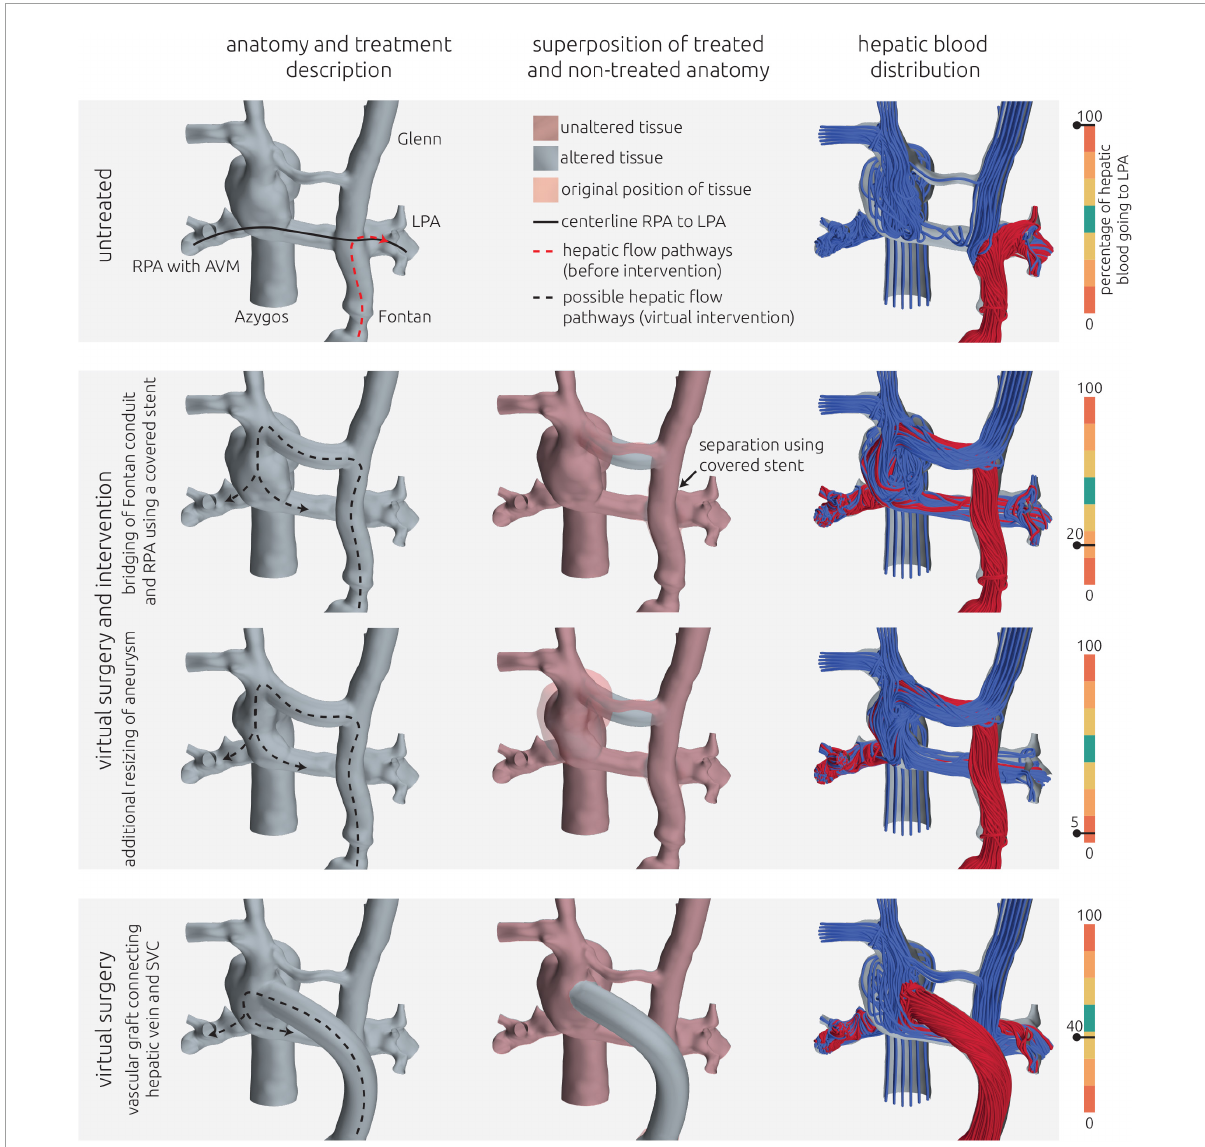
FIGURE7 Visualization of the estimated distribution of hepatic venous blood flow to the pulmonary arteries for the untreated patient-specific anatomy (top row) as well as two combined approaches using surgery and interventional techniques (middle rows) and one surgical treatment option (bottom row) for patient 2. In the left column, the anatomy of the conduit is shown together with the centerline from LPA and RPA (constant line) and the possible flow pathways for hepatic blood (dashed lines). The original pathways are highlighted in red, whereas the altered pathways after virtual treatment are shown in black. In the central row, the untreated anatomy is superimposed as transparent red surface over the virtually modified anatomy, highlighting all regions that were altered. The right column shows the calculated distribution of hepatic blood (red) into the LPA and RPA, as well as the distribution of blood coming from all other veins (blue). Hepatic blood flow distribution is indicated by the gauge to the